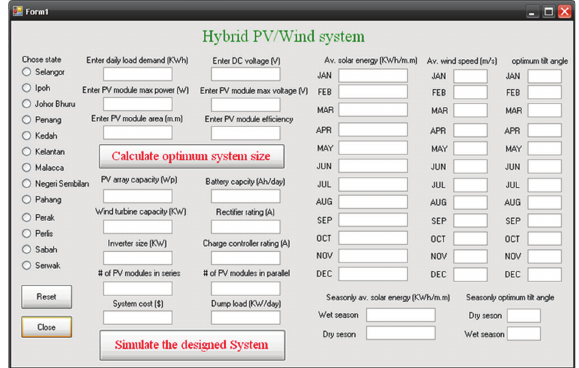
Figure 5: Interface for designing hybrid PV/wind system.